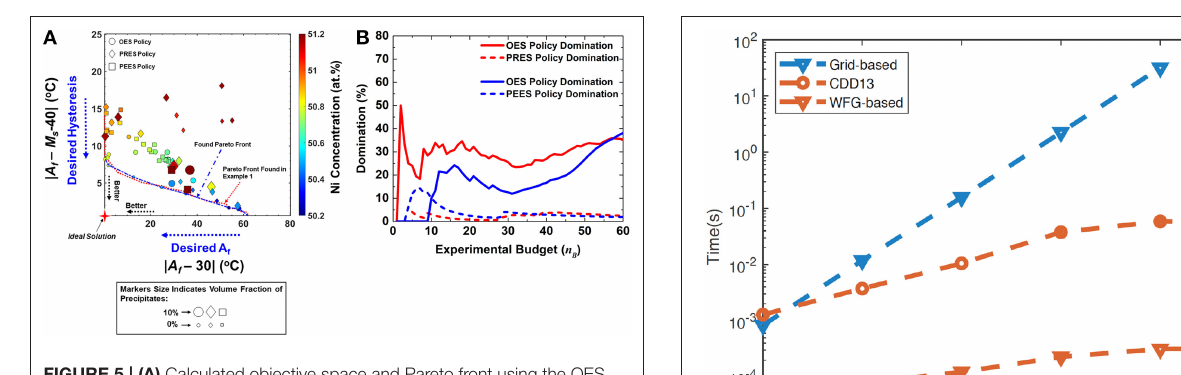
FIGURE 5 | (A) Calculated objective space and Pareto front using the OES, PRES and PEES policies under the n B = 20 experimental budget. Reproduced with permission from Solomou et al. (2018), (B) Comparison of the utility of the queried materials by the OES, PRES and PEES policies as function of the experimental budget for the 2-objectives materials discovery problem. Reproduced with permission from Solomou et al. (2018).